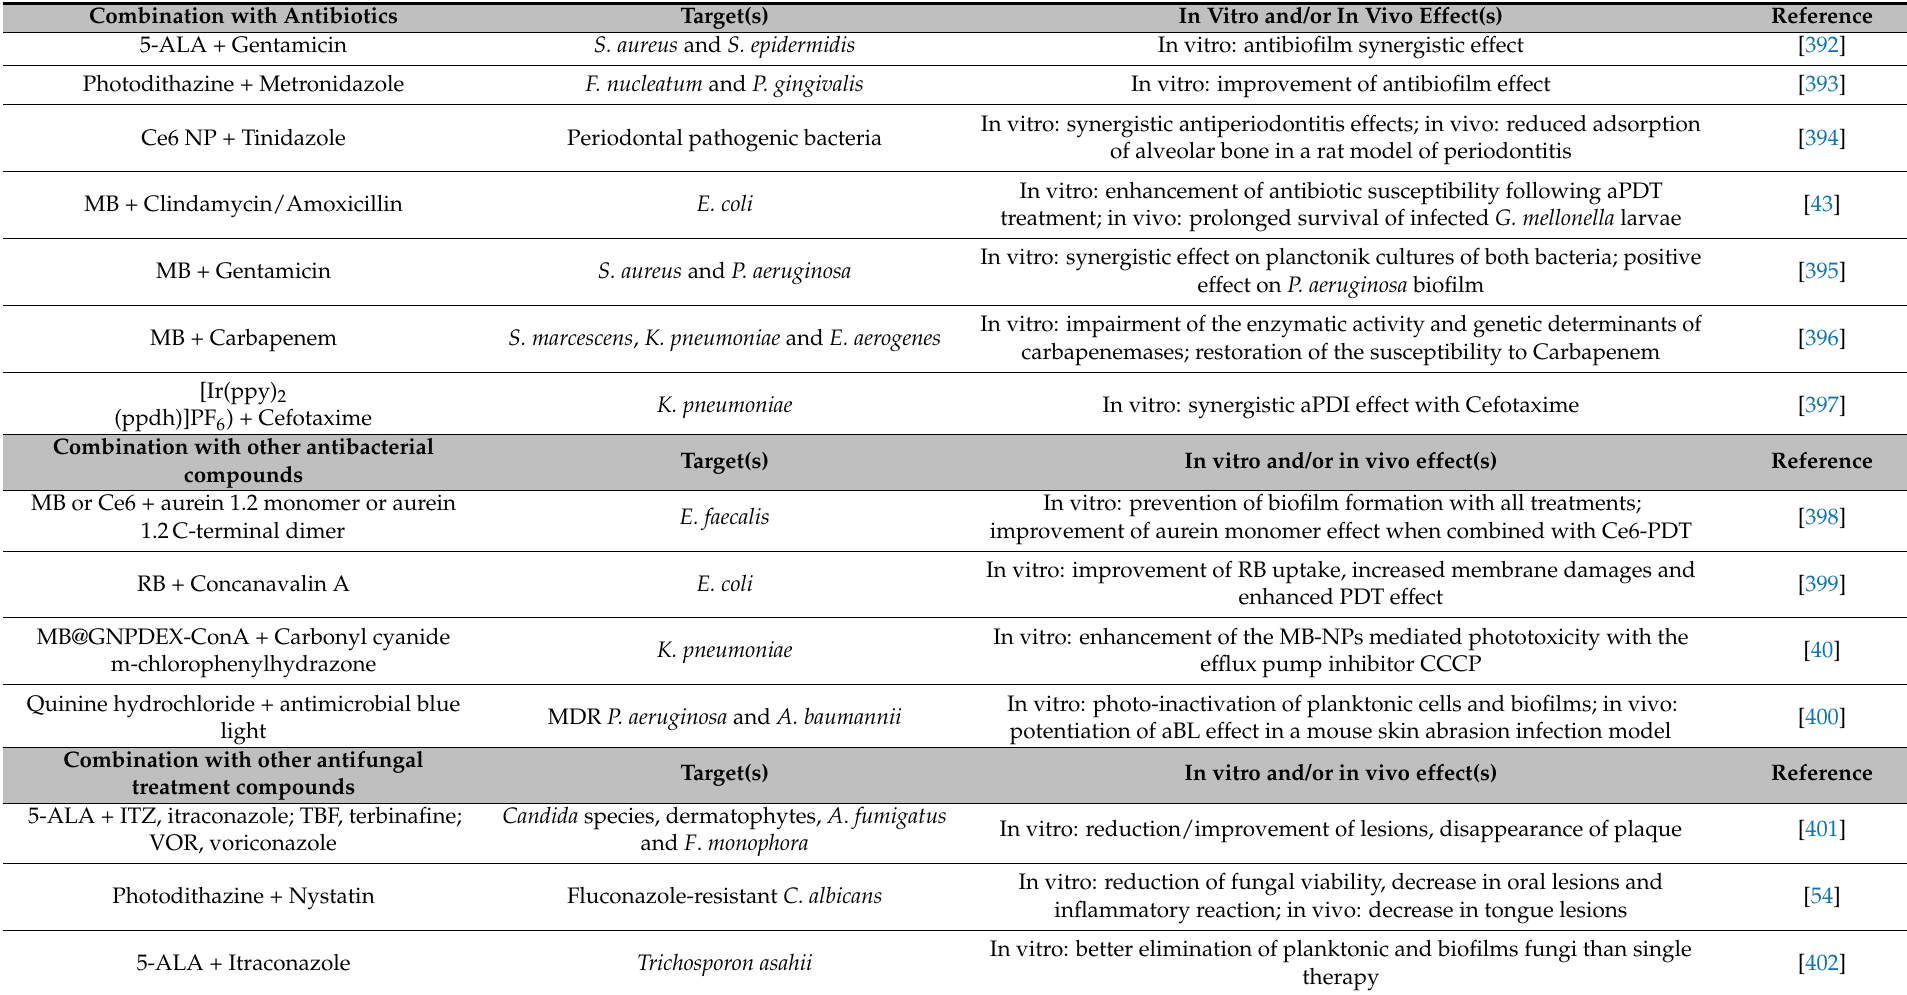
Table 2. Examples of recent studies that combined aPDT with other antimicrobial actives or